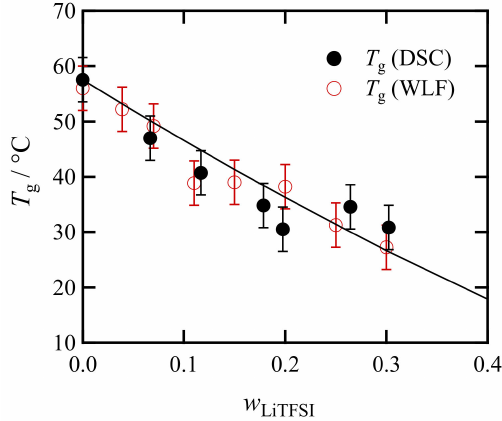
Figure 5. Dependence on the LiTFSI concentration for the glass transition temperatures measured by DSC ( T g (DSC)) and estimated from the viscoelastic shift factors ( T g (WLF)) explained in the Appendix A section. The solid curve represents the fit functions given by Equation